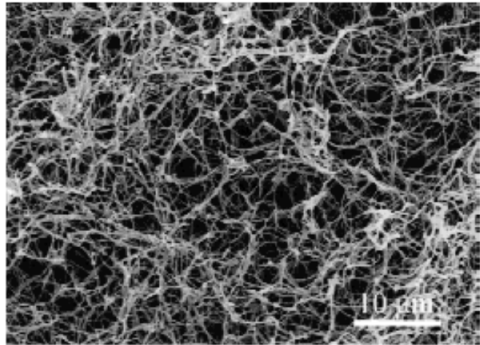
Figure 4. Scanning electron microscopy (SEM) micrograph of poly- L -lactic acid (PLLA) nanofibrous meshes prepared from a 5 w/v % PLLA/tetrahydrofuran (THF) solution at 8 °C—reproduced. Reproduced with permission from [62], Copyright Wiley, 1999.